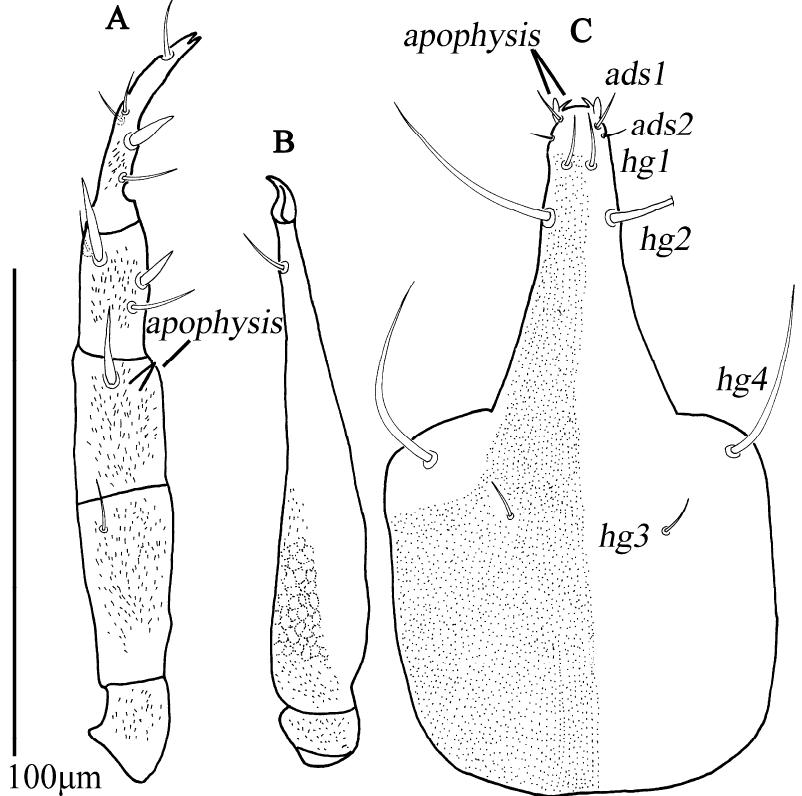
Figure 7. Cunaxicaudus mohanensis sp. nov. (male). ( A )—Palp. ( B )—Chelicerae. ( C )—Subcapitulum. Scale bar = 100 µm.